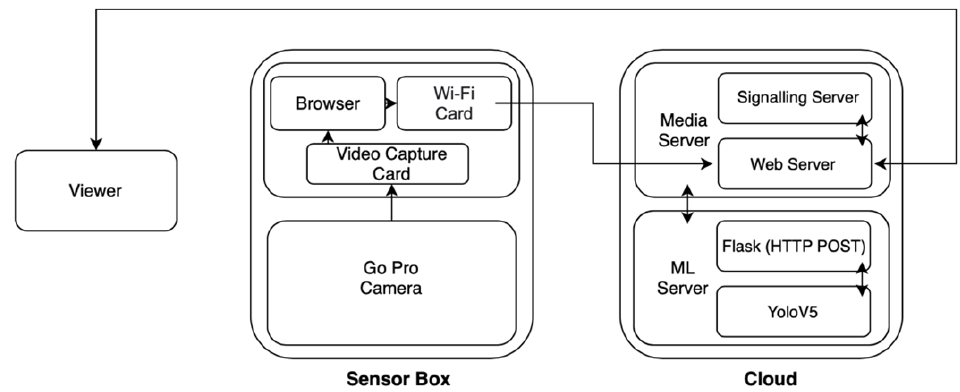
Figure 6. System architecture for the external sensor box carried by the